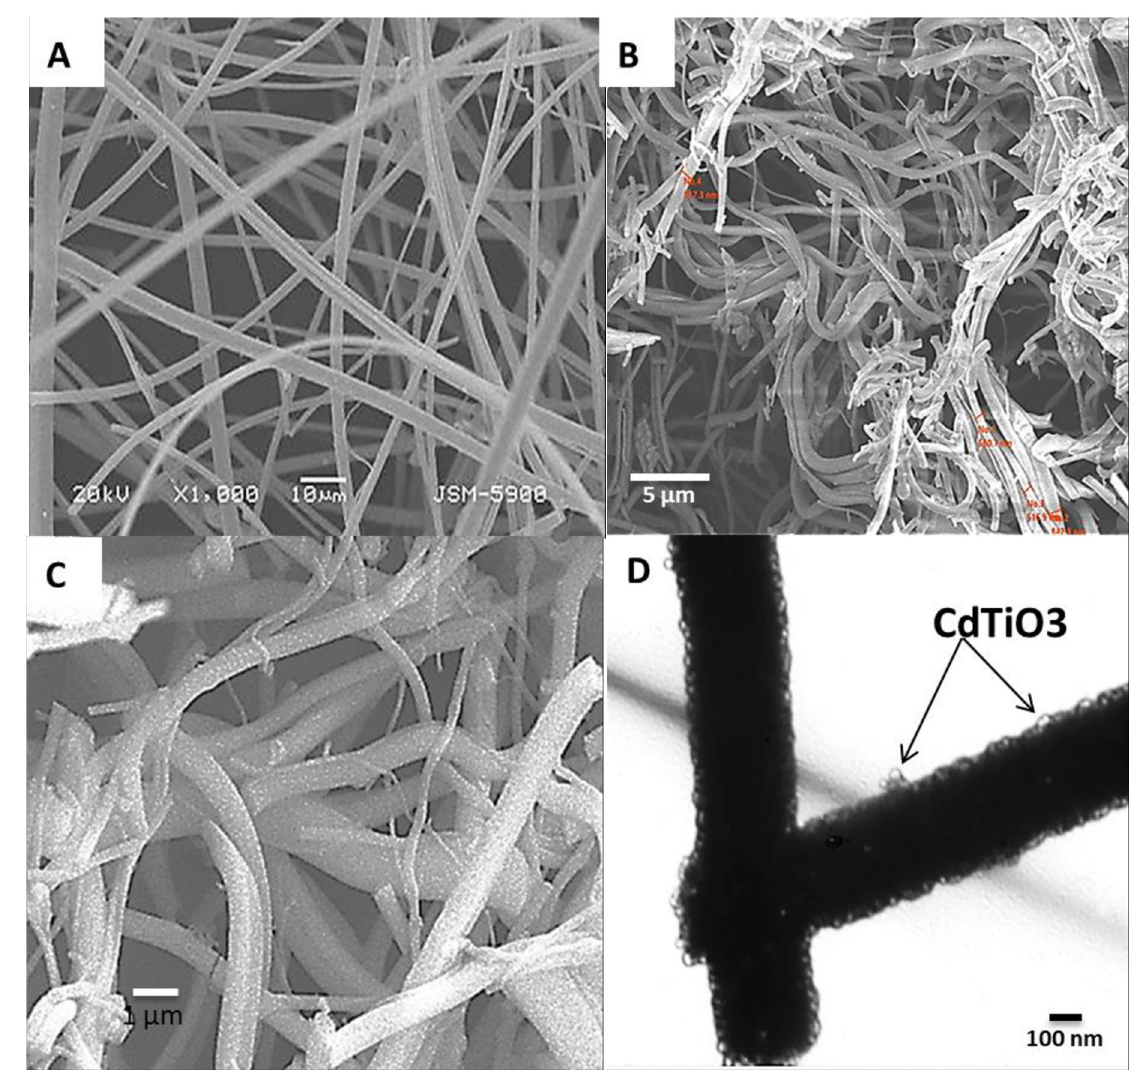
Fig 2. SEM images for pristine; (A) and 0.5 wt% Cd-doped TiO 2 ; (B) produced nanofibers after the calcination process. (C) magnification of 0.5 wt% Cd-doped TiO 2 nanofiber indicating the corrugated/speckled surface of the nanofiber. (D) TEM image of Cd-doped TiO 2 nanofiber indicating the attach of CdTiO 3 over the surface of TiO 2